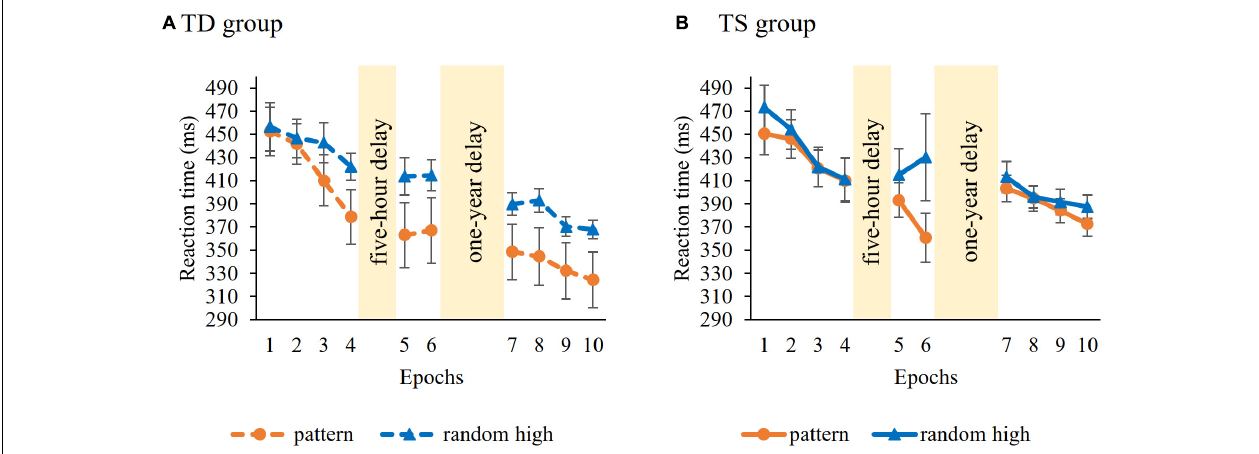
FIGURE 3 | Temporal dynamics of learning of serial-order regularities across epochs and sessions in the (A) TD group and (B) TS group. Dashed lines represent the TD group, continuous lines represent the TS group. RT values as a function of the epoch (1–10) and trial types (pattern vs. random high) are presented. Orange lines with circle symbols indicate RTs on the pattern trials, blue lines with triangle symbols indicate RTs on the random high trials. Learning is quantified by the gap between orange and blue lines; the greater gap between the lines represents better learning. Error bars denote standard error of mean.